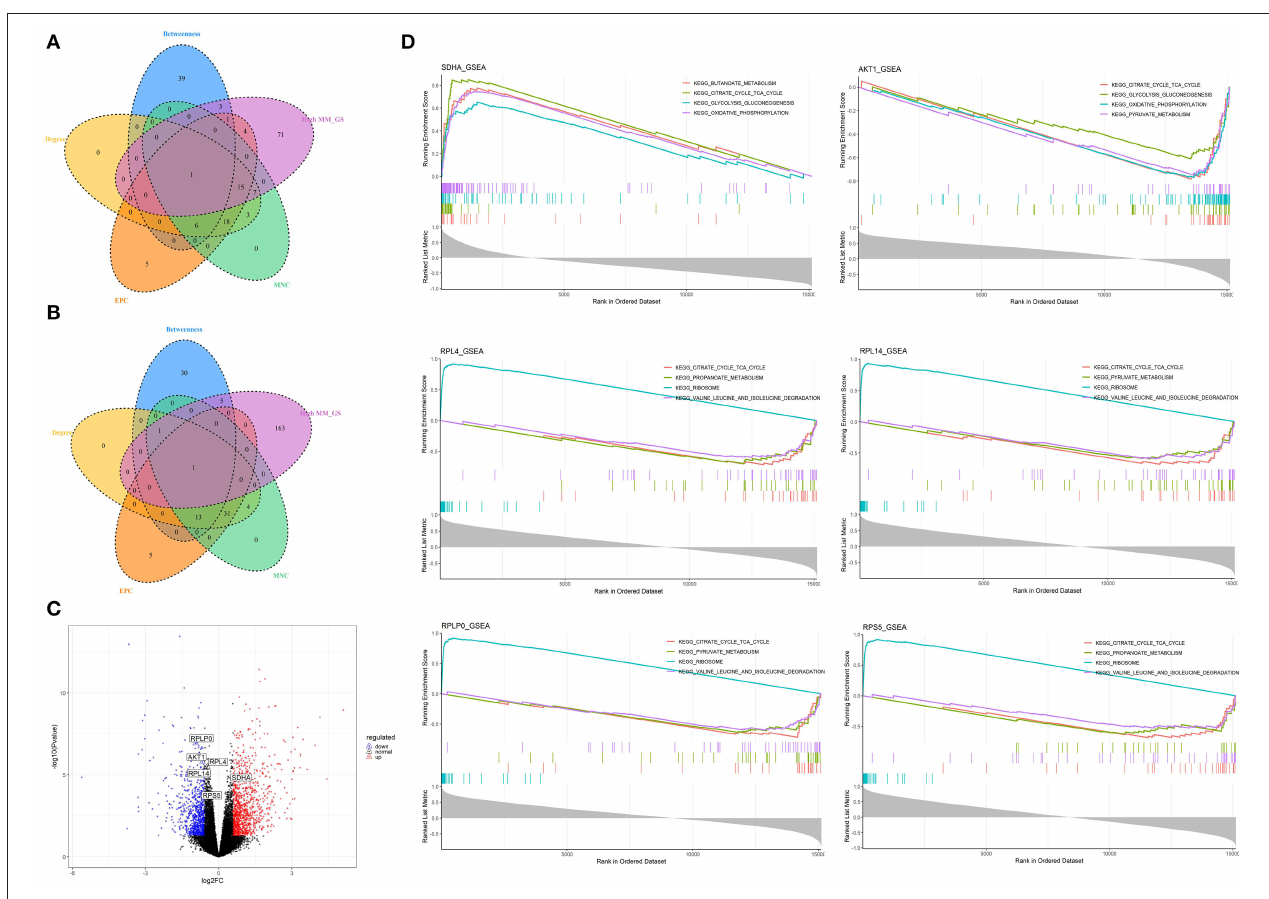
FIGURE 7 | Identification and analysis of hub genes related to nutrition levels in visceral adipose tissue. (A,B) The intersection of the potential hub genes and the top 50 hub genes identified by four algorithms (MNC, EPC, Betweenness, and Degree) in the blue module (A) and brown module (B) . (C) Volcano plot of differential expressed genes between high and low nutrition levels. Red and blue dots represent the upregulated and downregulated genes comparing the high nutrition group with the low. The identified hub genes are labeled with the triangle. (D) GSEA analysis of hub genes related to nutrition levels in visceral adipose tissue. The horizontal axis represents the ranked gene list according to the correlation with the hub gene. The vertical axis represents enrichment scores (upper) and the correlation coefficients with the hub gene (lower). Each color represents a pathway marked in the upper right